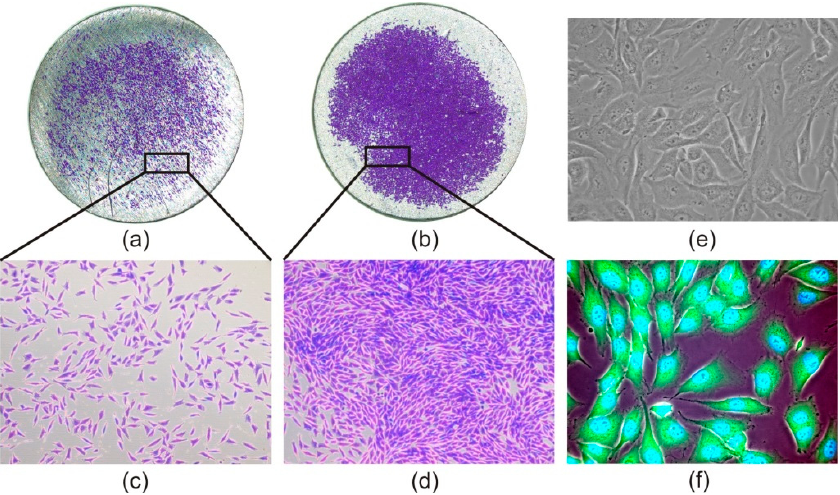
Figure 5. Microscopic images of cell morphology. Human osteoblast like cells MG-63 stained with crystal violet on nanostructured titanium sample in magnification 20× ( a , b ) and 100× ( c , d ). Native osteoblasts in bright field on tissue culture plate ( e ) and fluorescence image of MG-63 cells on tested titanium material ( f ), both in 400 × magnification.